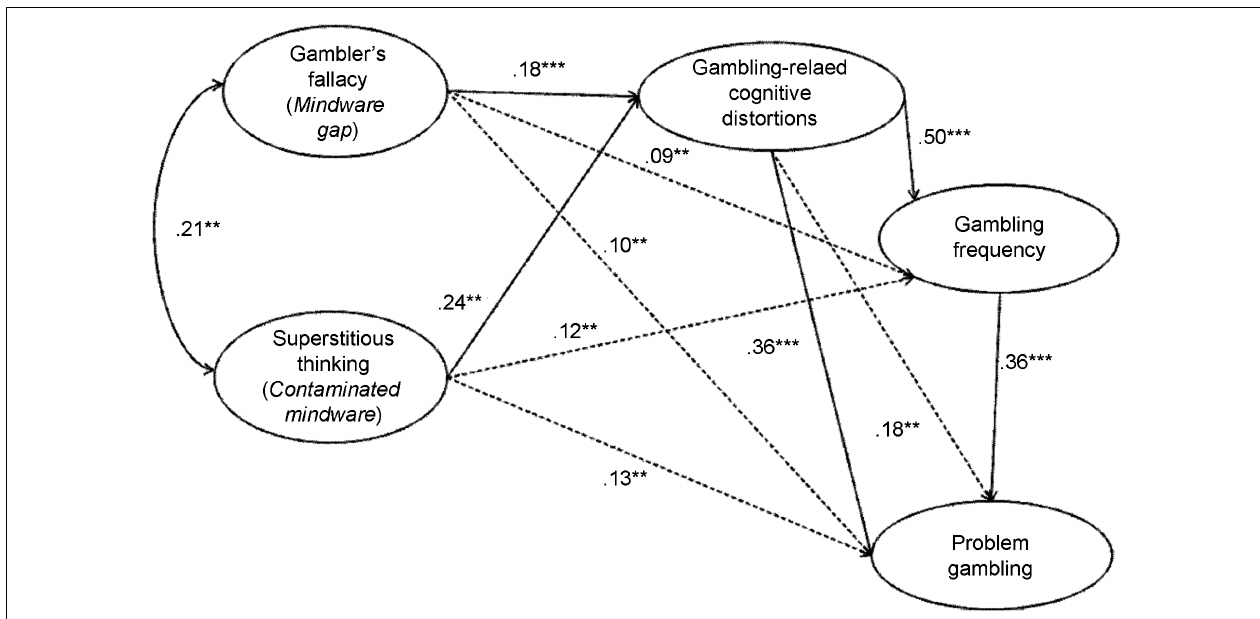
FIGURE 1 | Model of problem gambling with standardized parameters (significant path coefficient ∗∗∗ at the 0.001 level, ∗∗ at the 0.01 level). Dotted lines represent indirect effects, while continuous lines indicate direct